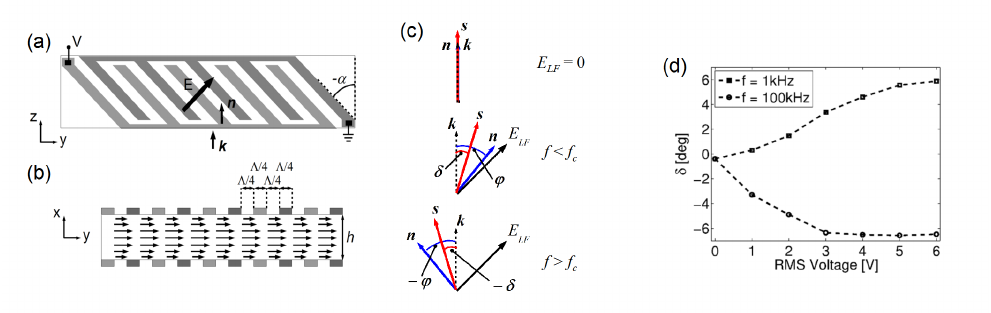
( c ) Sketch of the electrically-driven reorientation: the director ˆ n and the Poynting vector s tend to reorient towards (positive anisotropy) or away from (negative anisotropy) the electric field vector at frequencies below or above the crossover value, f of the measured walk-off versus voltage for positive ( f = 1 kHz, squares) and negative ( f = 100 kHz, dots) NLC anisotropies and director rotations,